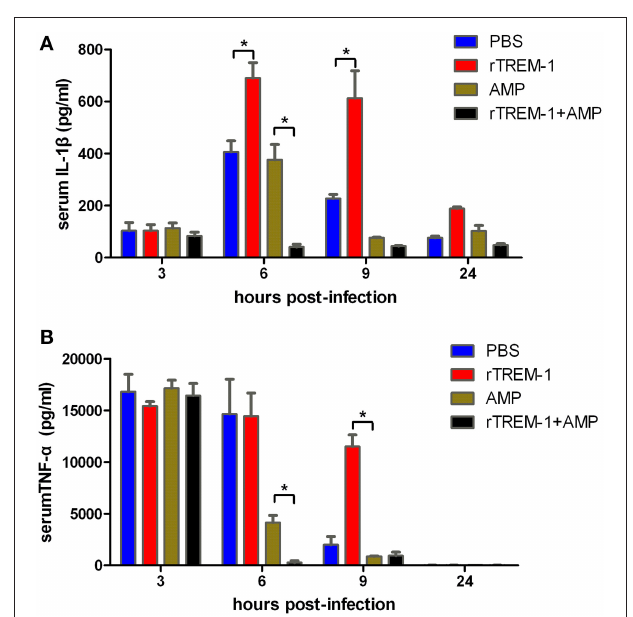
FIGURE 1 | Combined treatment with rTREM-1 and antibiotics protects mice against S. suis infection. (A) Survival of mice infected with a highly virulent S. suis strain. The mice were treated with PBS, rTREM-1, antibiotics, or antibiotics+rTREM-1 at 3h post-infection. (B) The daily body weight of mice infected with highly virulent S. suis . “ * ” represents p < 0.05 for the selected two groups.